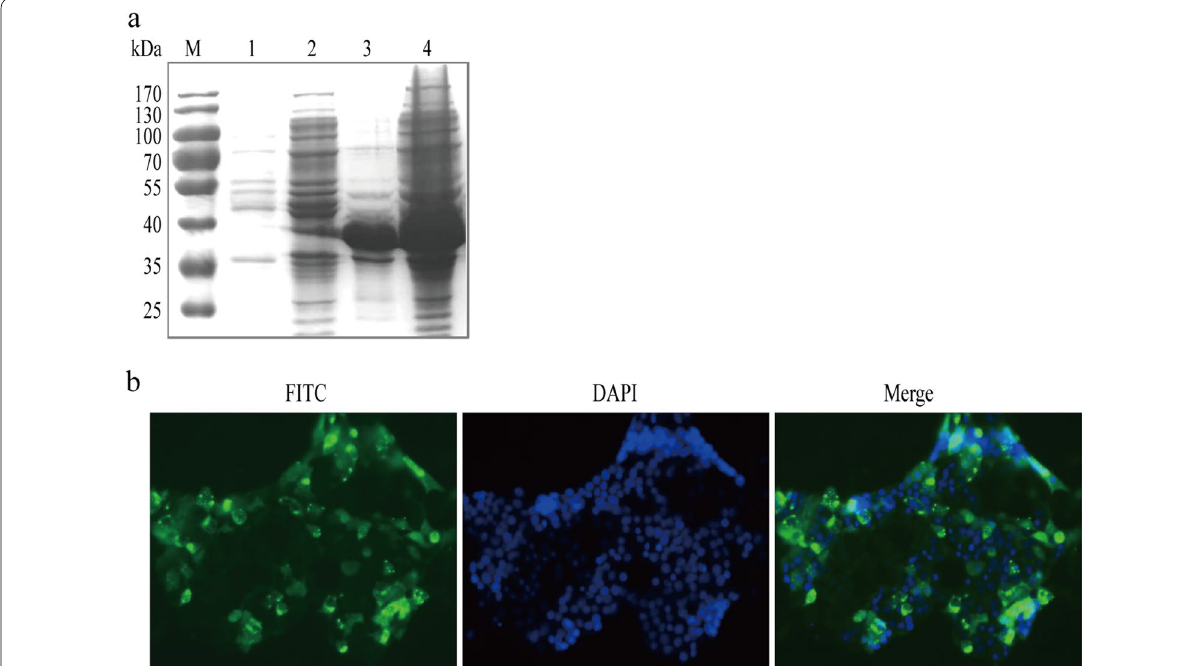
Fig. 1 Characterization of the generated mAb 3G8. a The N-terminus of Hexon peptide (1-293aa) of FAdV-4 was expressed and analyzed by SDS-PAGE. 1, empty vector; 2, non-induced BL21 (DE3) transformed with pET30a ( )-hexon879; 3, purified Hexon protein; 4, induced BL21 (DE3) + transformed with pET30a ( )-hexon879. b The mAb 3G8 reacted with the Hexon protein expressed in cell by IFA. pcDNA3-hexon879 plasmid was + transfected to LMH cells. At 70 h post-transfection, the cells were fixed and incubated with mAb 3G8 for 30 min. Following three washes with PBS, the cells was incubated with FITC-conjugated anti-mouse antibody and examined under an Axiophot Photo